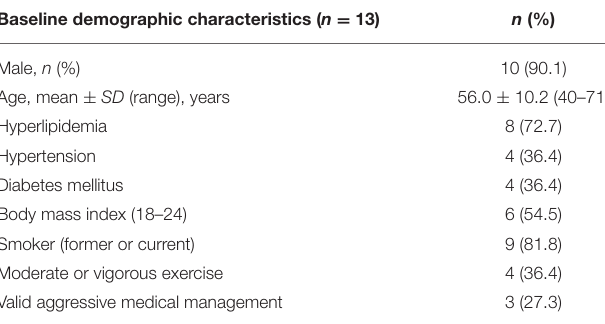
TABLE 1 | Baseline demographic characteristics.